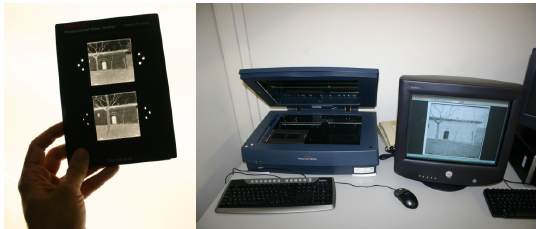
Figure 3. Slide holder for 6x6 cm analog negatives (left) and scanning device employed (right).